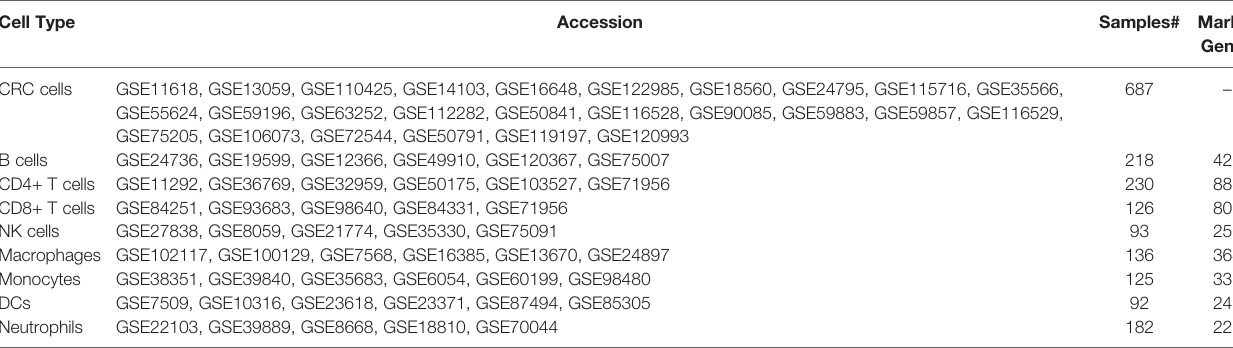
#, number; CRC, colorectal cancer; NK cells, natural killer cells; DCs, dendritic